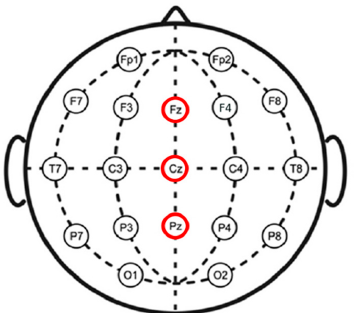
Figure 2. The 19 electrodes based on the 10–20 system.